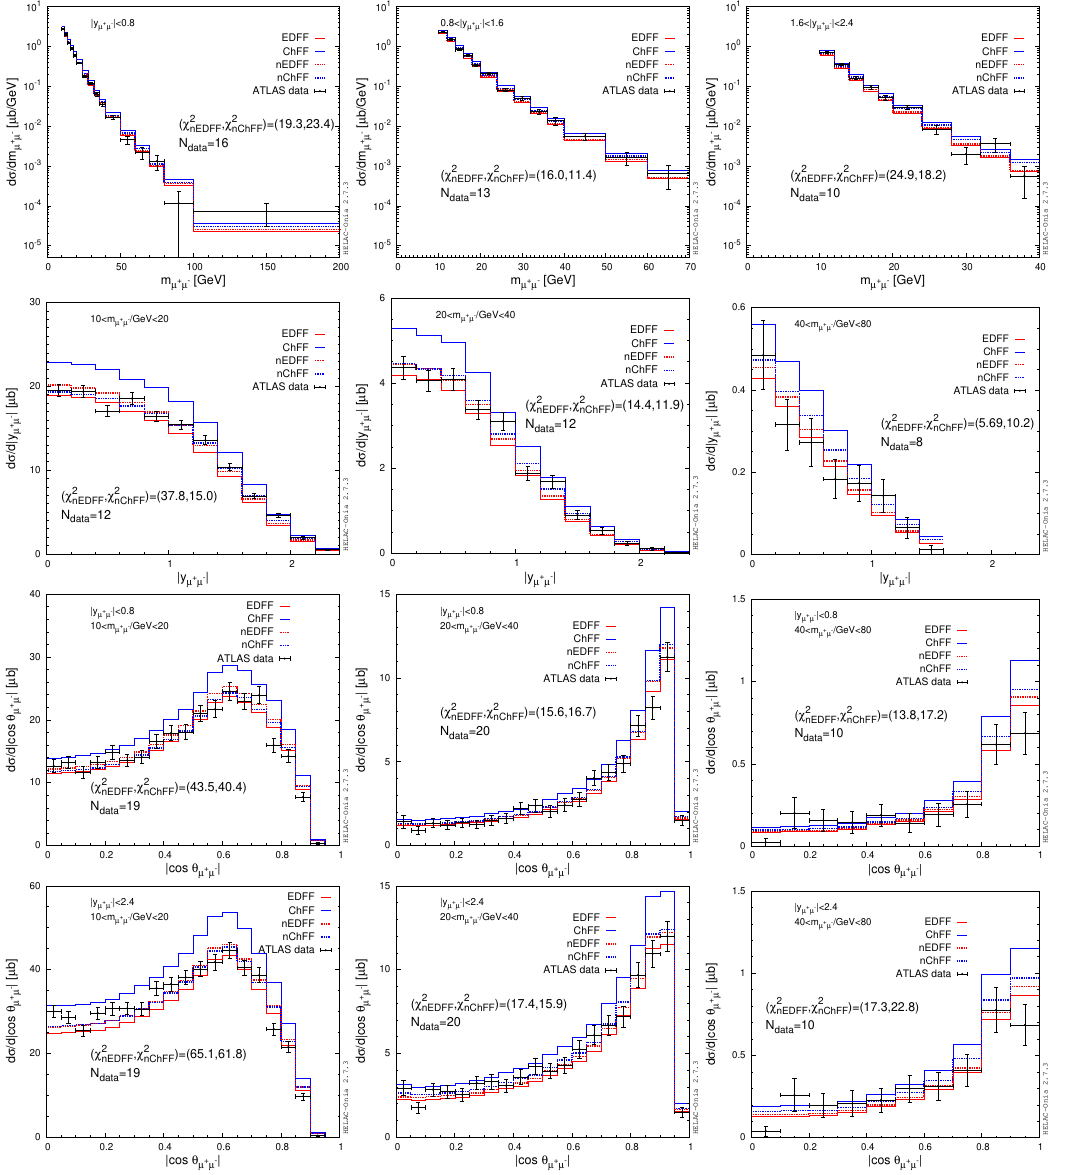
p = 5 : 02 TeV as s NN